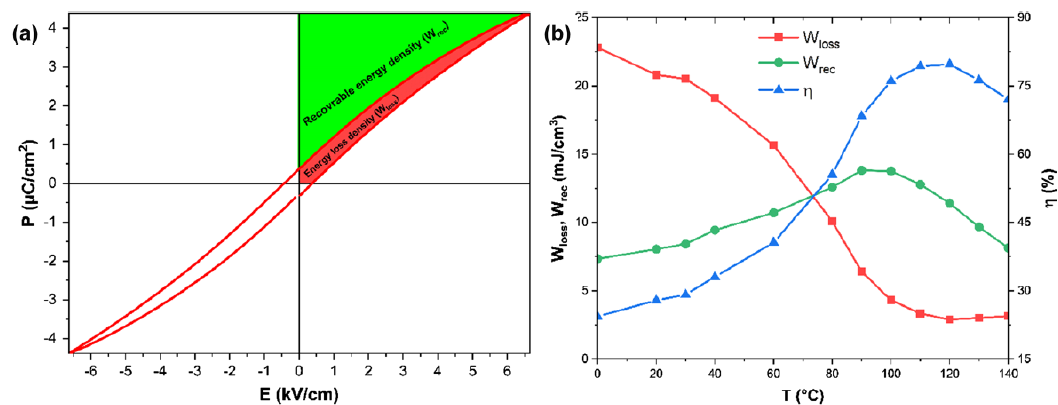
Figure 5. P – E loop at 120 °C with schematic calculations energy storage efficiency ( a ) and variation of recoverable energy density, energy loss density, and the energy storage efficiency of the BCZT ceramic with temperature ( b ). Reprinted with permission from [55]. Copyright 2019 Springer Nature.